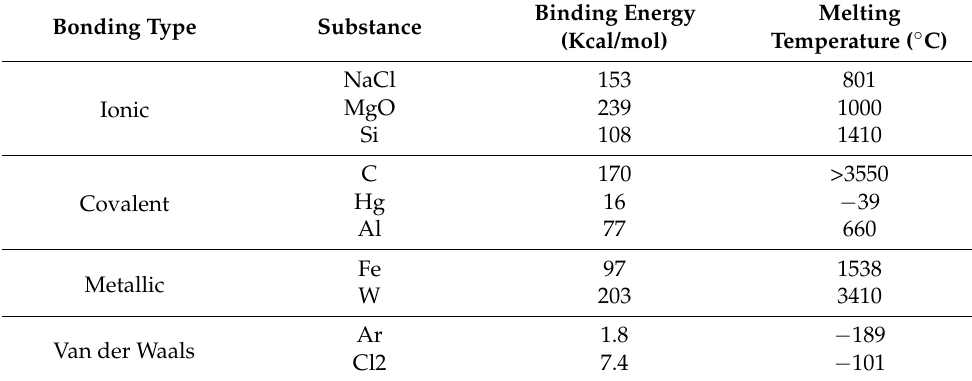
Table 1. Binding energy and melting temperature of different bond types